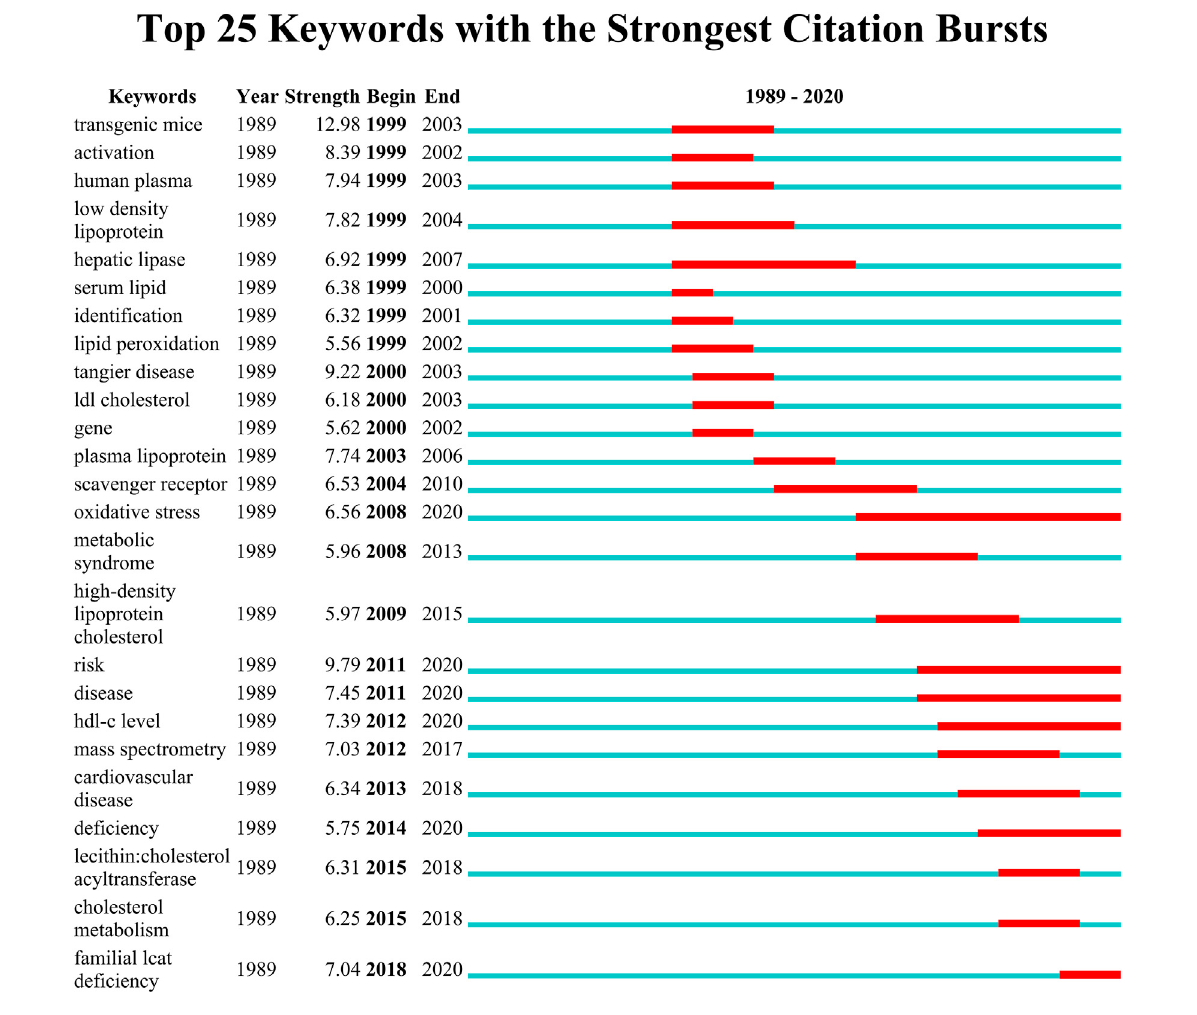
FIGURE 9 The keywords with the strongest citation bursts for publications on LCAT-related studies from 1985 to 2020. The red line indicates the time period when the keyword had a burst.